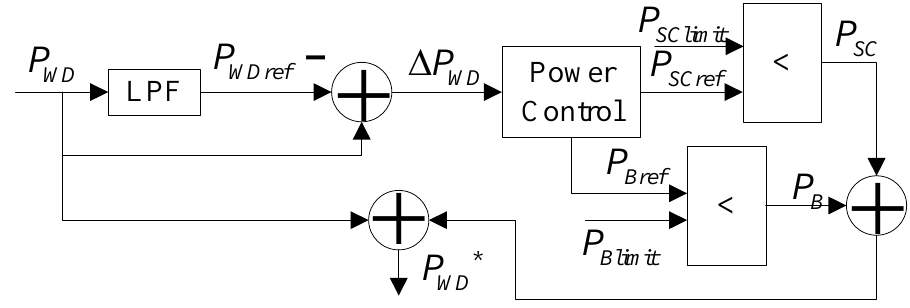
Figure 2. Control diagram of wind-energy storage system.